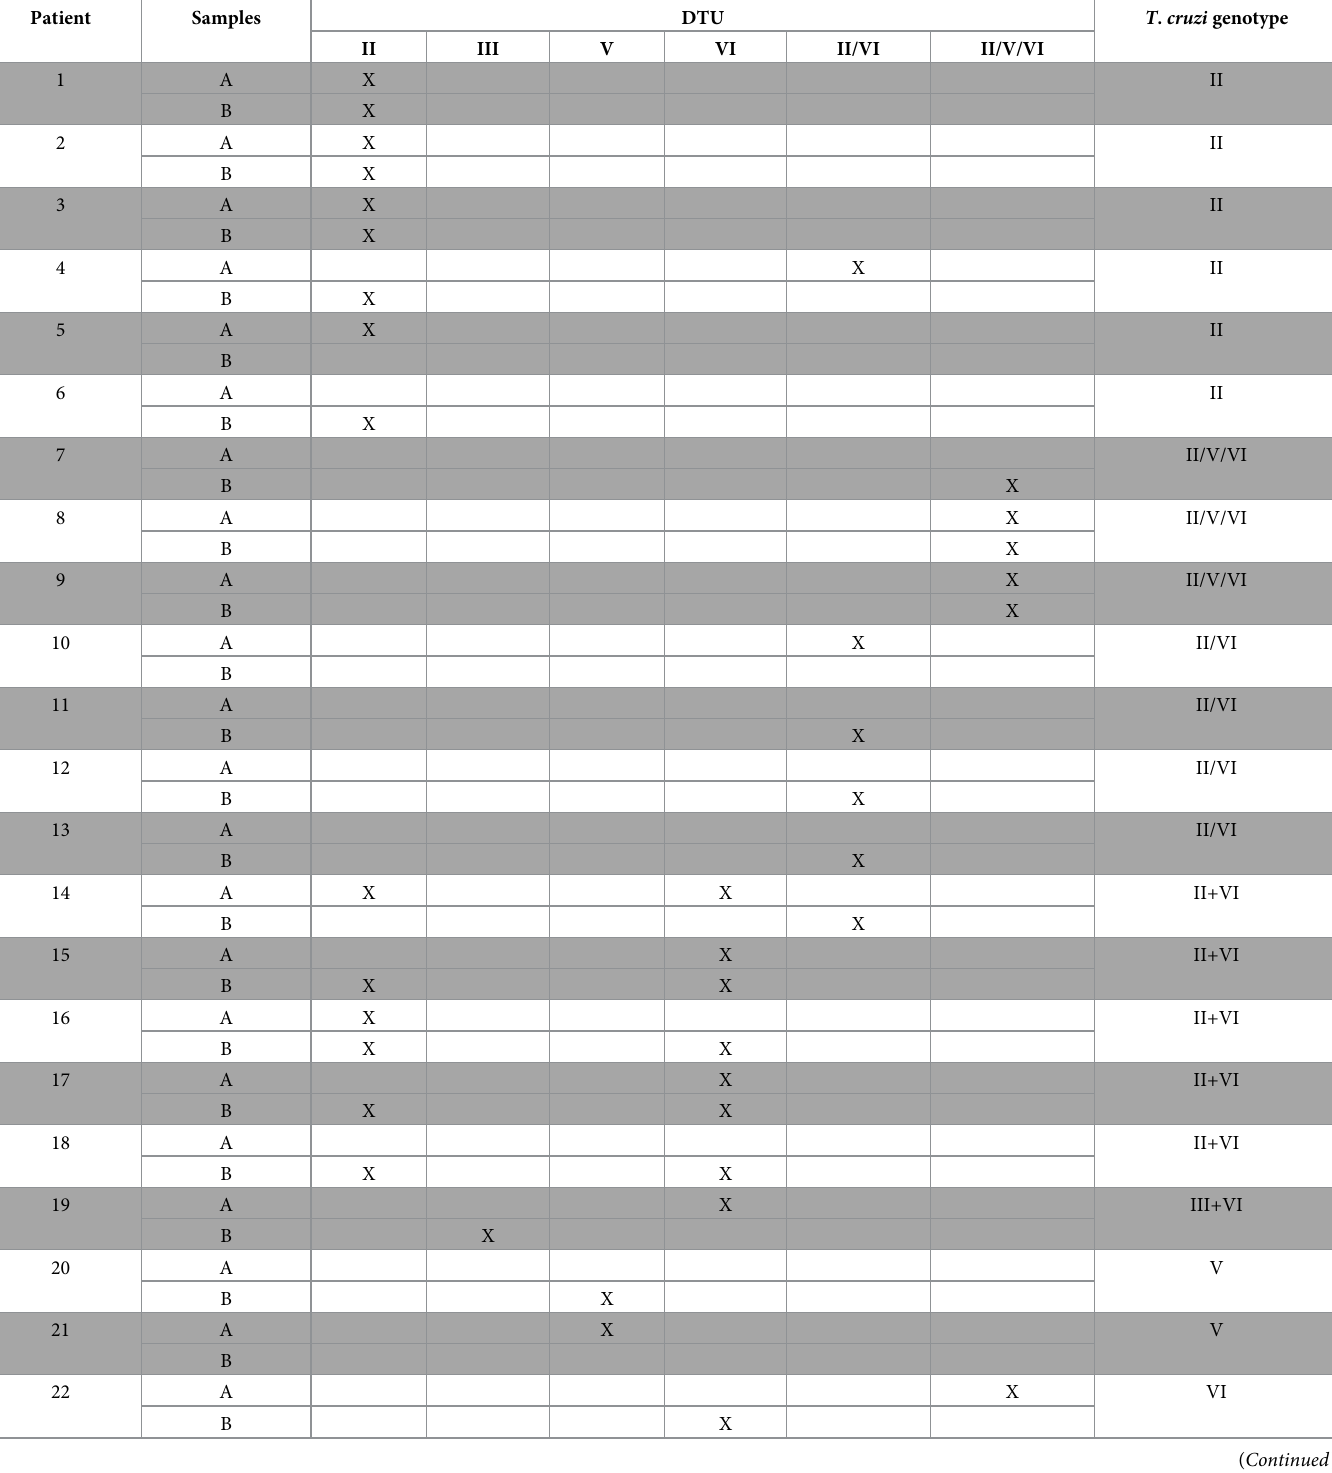
Table 3. Molecular typing of T . cruzi from patient blood samples. Samples A and B correspond to the DNA duplicates from the same patient, used for the genotyping assays. According to the genotyping flowchart (Fig 3), X represents the T . cruzi genotype in each